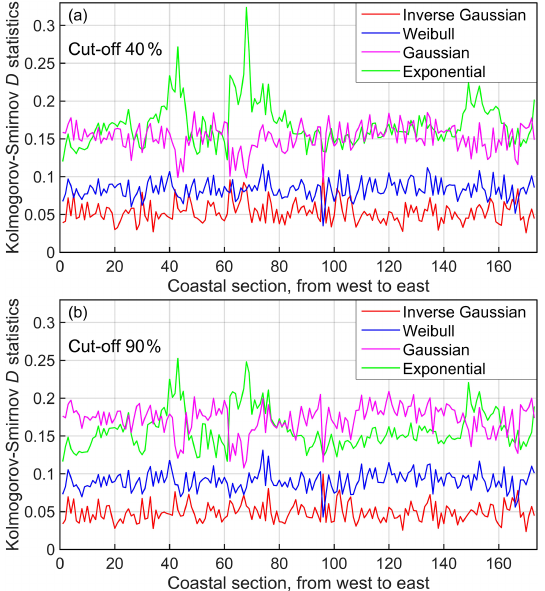
Figure 13. Alongshore variation in the D value of the Kolmogorov– Smirnov test for the goodness of fit of the empirical probability distribution of set-up heights with inverse Gaussian, Weibull, expo- nential, and Gaussian distributions for different cut-off values (40% and 90% of the maximum set-up height in a particular coastal sec-